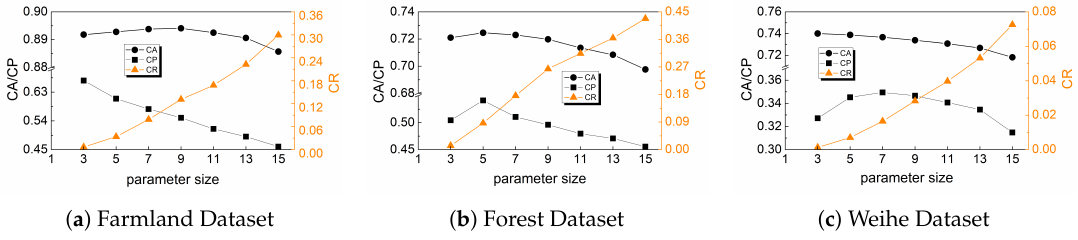
Figure 10. Relationship between parameter size and the result of pre-classification.